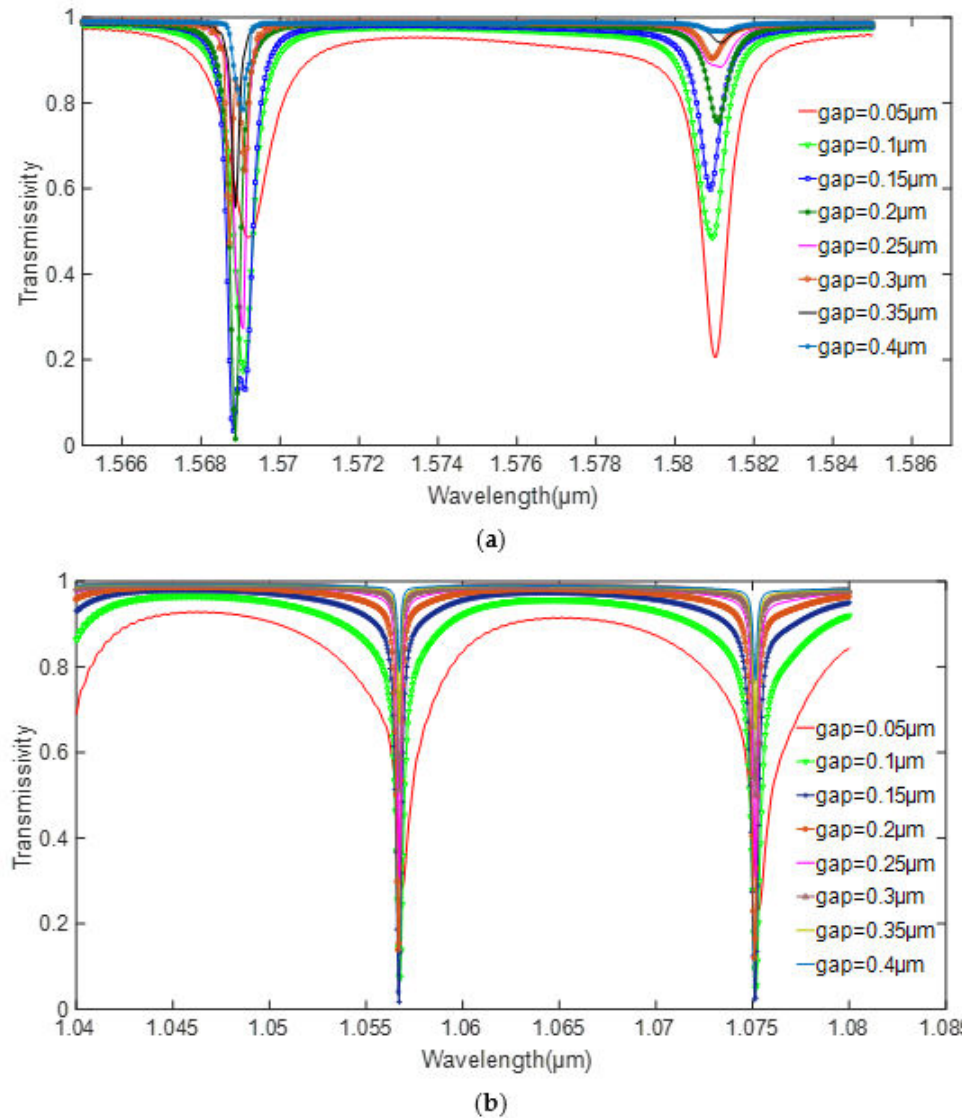
Figure 6. Relationship between the transmissivity and coupling gap. ( a ) silicon. ( b ) silicon